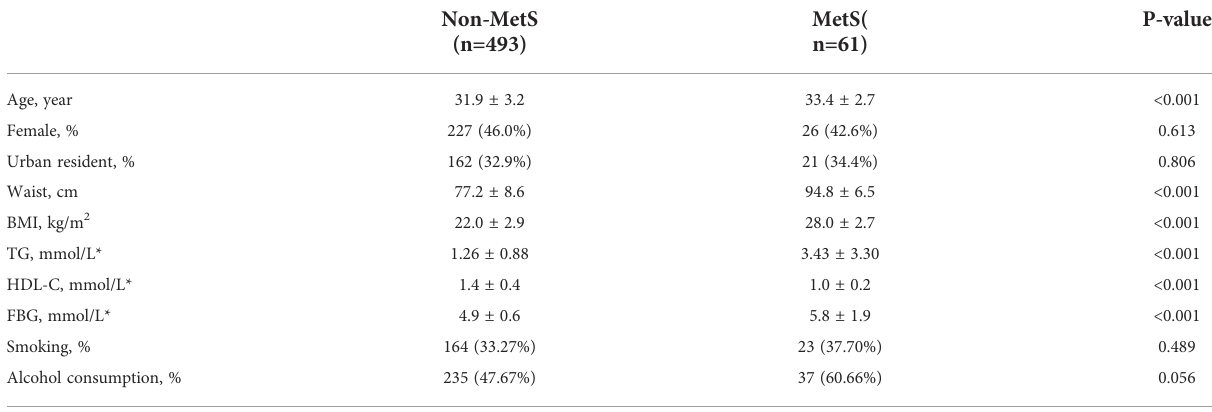
TABLE 1 Baseline characteristics by cumulative incident MetS at follow-up.